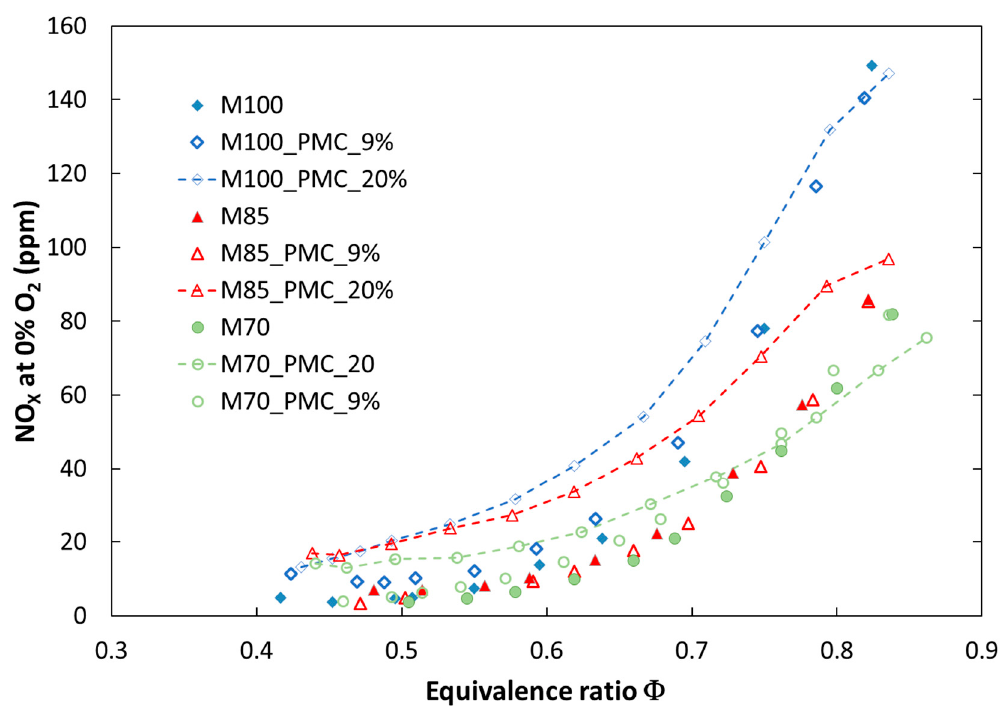
Figure 8. Comparison of experimental NO X emissions for tested fuels for various configurations of the combustion process at atmospheric pressure (P = 0.1 MPa).